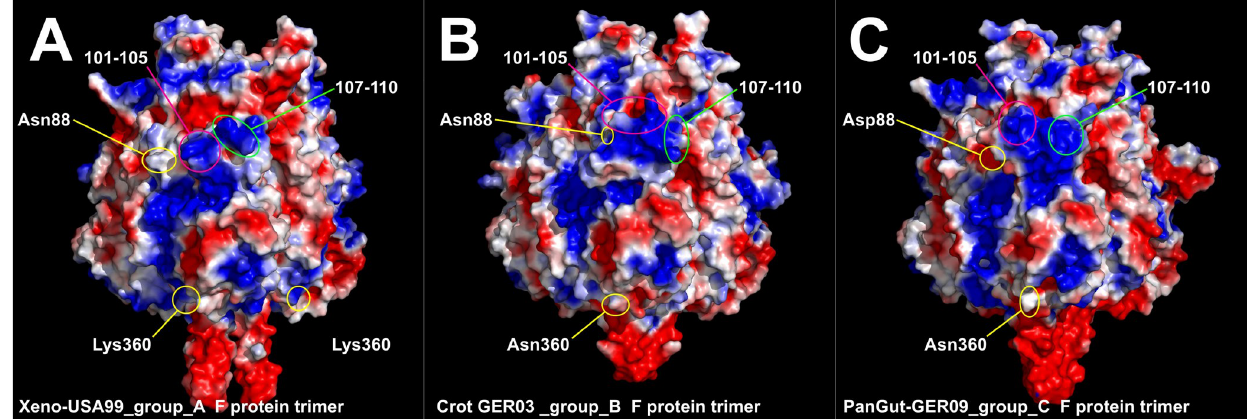
Fig 4. Electrostatic surface view of ferlavirus fusion protein dimers. Red represents regions with potential values less than -2.0 kT; white represents 0.0; blue shows regions greater than +2.0 kT. Amino acids in position 88 and 360 are indicated in panel A, B, and C, respectively.